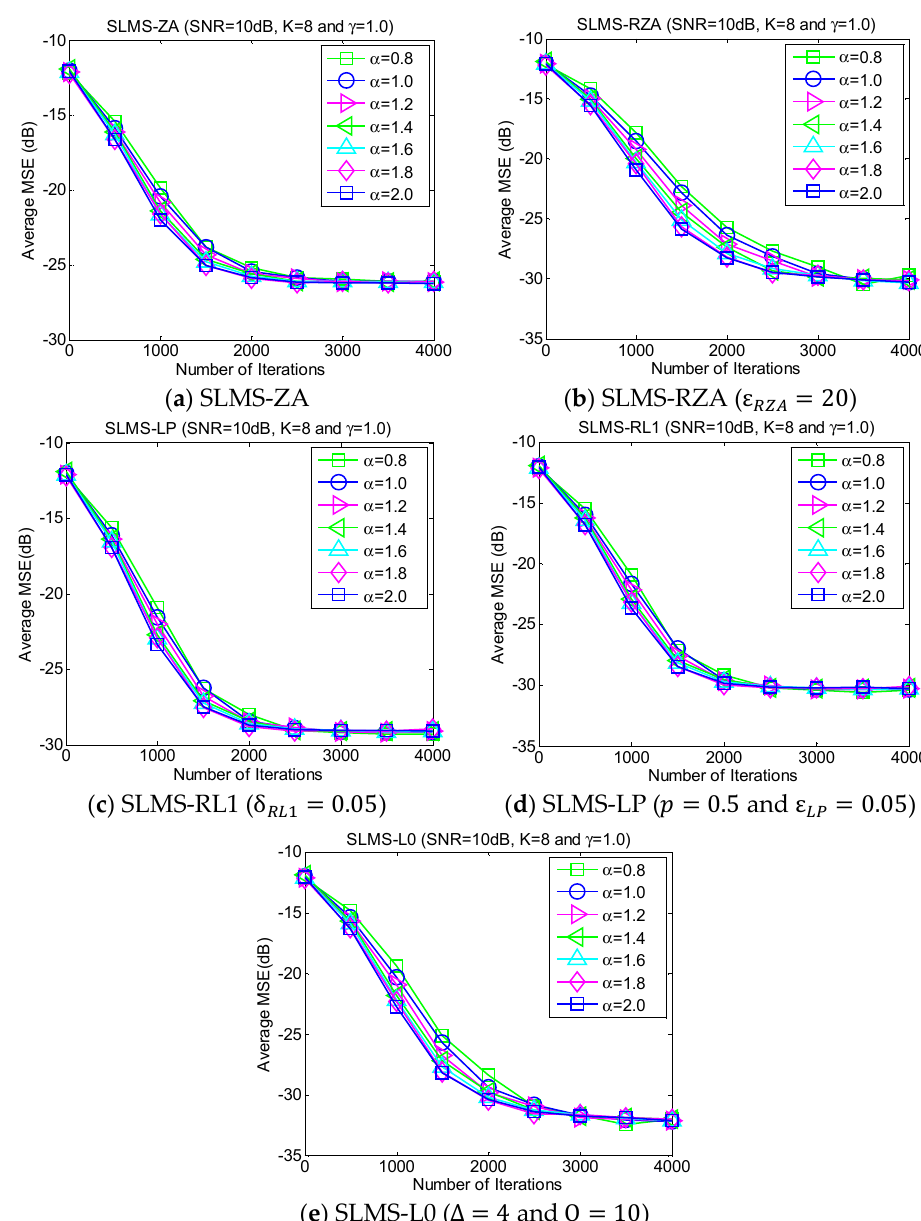
Figure 4. Monte Carlo based MSE curves averaging over 1000 runs with respect to different characteristic exponents α ∈ { 0.8, 1.0, 1.2, 1.4, 1.6, 1.8, 2.0 } , in scenarios of dispersion parameter γ = 1.0, channel length N = 128, channel sparsity K = 8, and SNR = 10